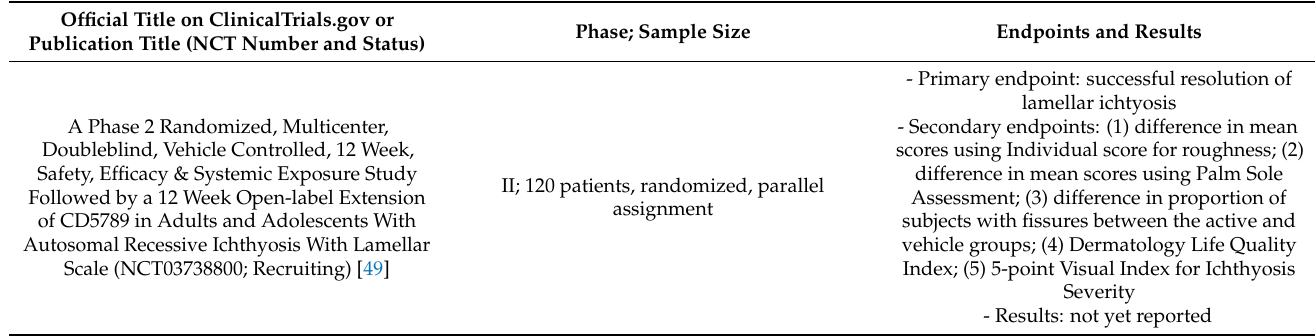
Table 4. Clinical trial evaluating trifarotene in lamellar ichtyosis with no results reported